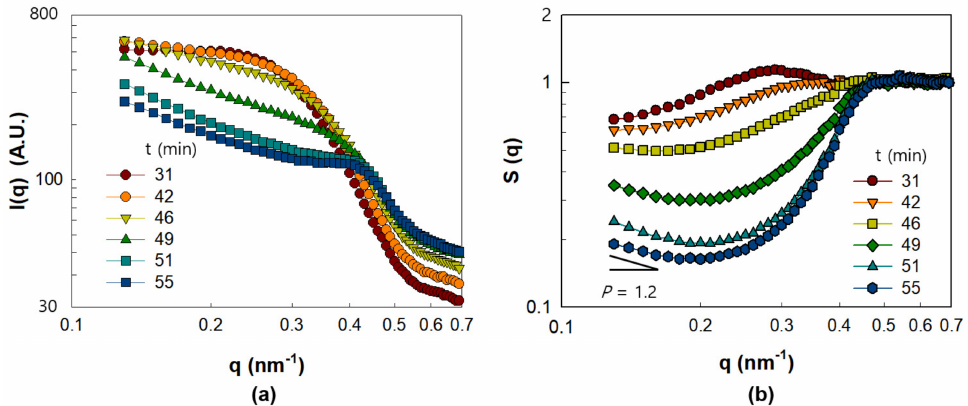
Figure 6. SAXS analysis result of silica-PVA film corresponding to Γ 0.09 in the range of drying time from 31 to 55 min. ( a ) I(q) and ( b )